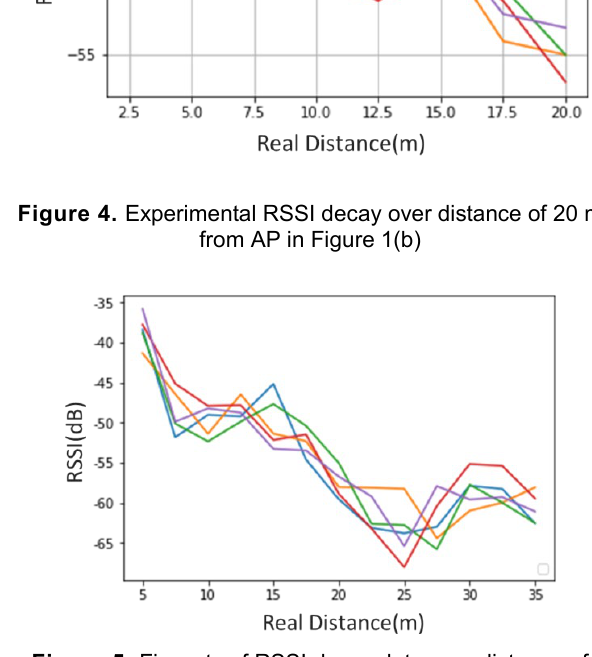
Figure 5. Fivesets of RSSI decay data over distance of 35 mfrom AP in Figure